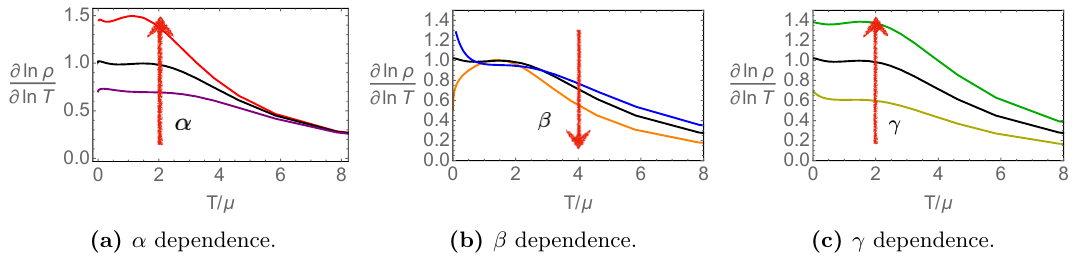
Figure 7. The exponent x in (cid:26) (cid:24) T x . The colors of the curves are chosen to be the same as the colors of the dots in (cid:12)gure